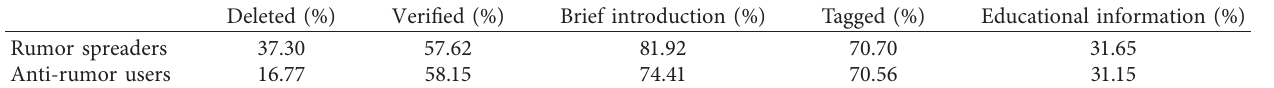
Table 2: Basic features between rumor spreaders and anti-rumor accounts.